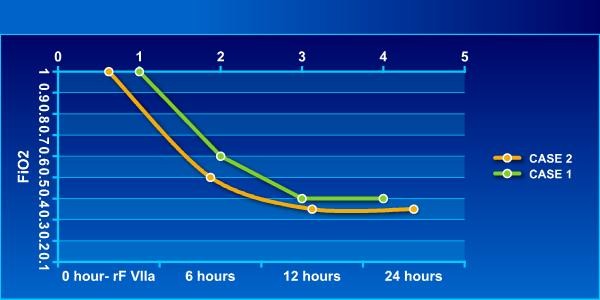
Changes in the FiO2 following rFVIIa administration in two cases treated with intrapulmonary rFVIIa.